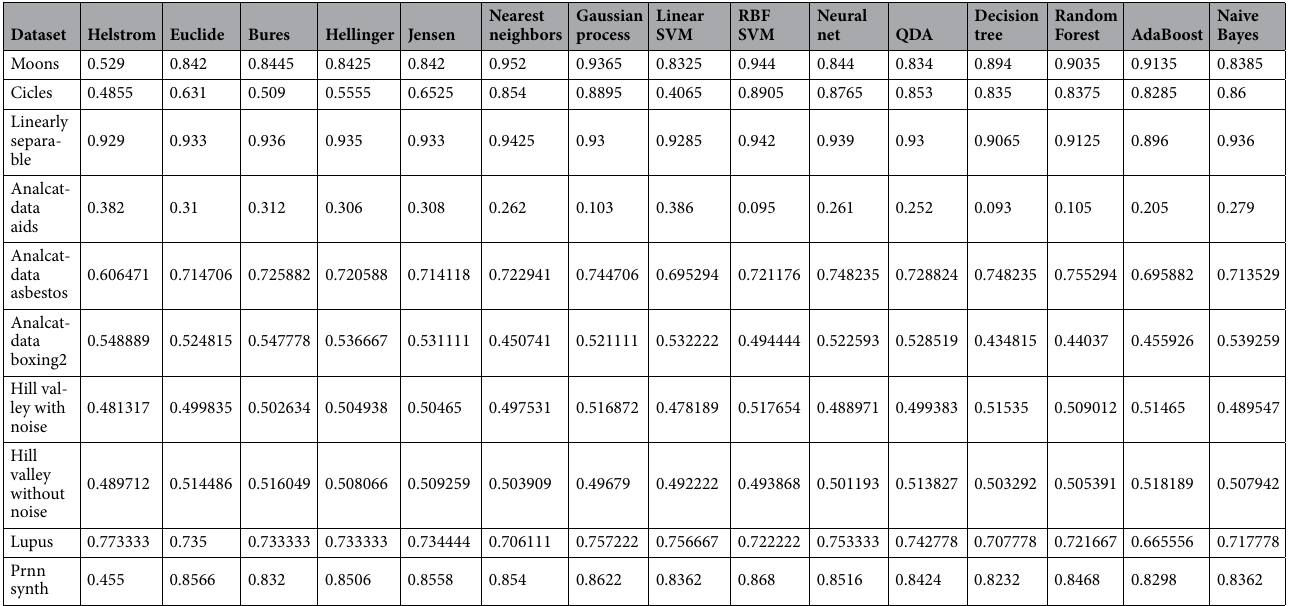
Table 1. Average accuracy with the first 2 features. The best result for each dataset is marked in bold.